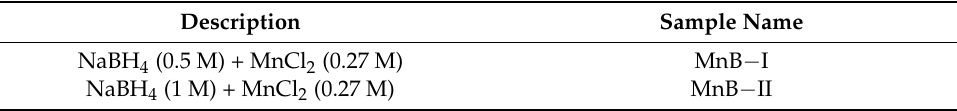
Table 1. Synthesis description and sample names used in this